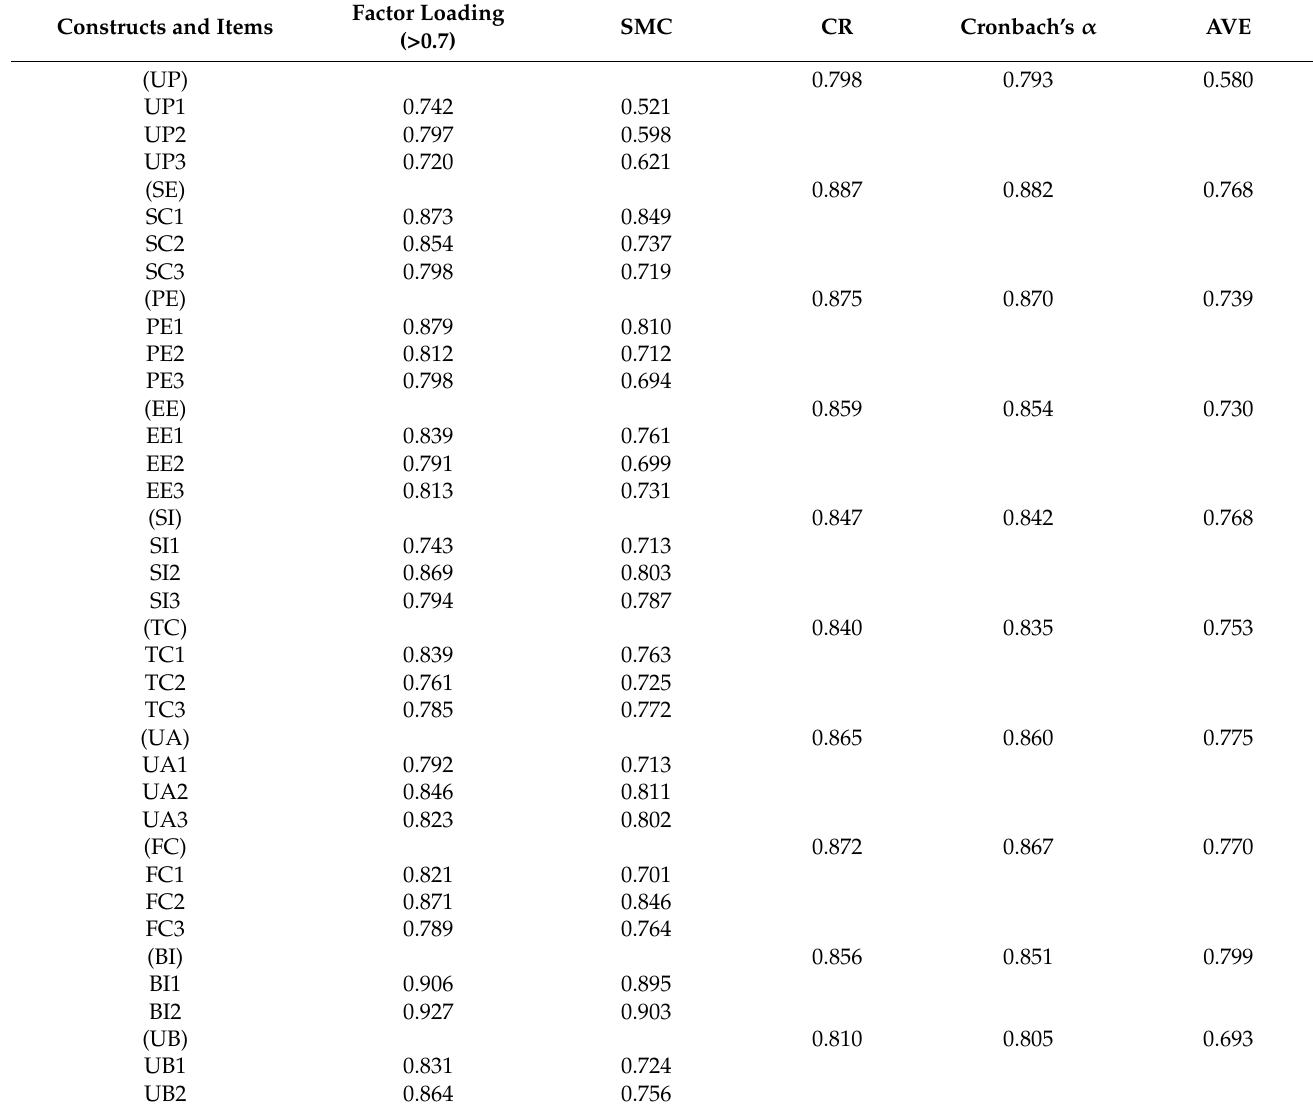
Table 4. Measurement model’s convergent validity and